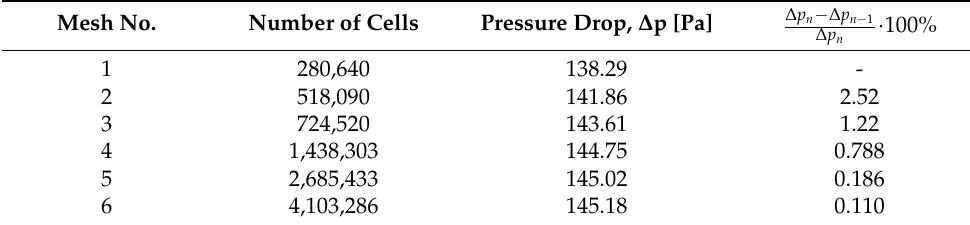
Table 2. Results of mesh independence tests.